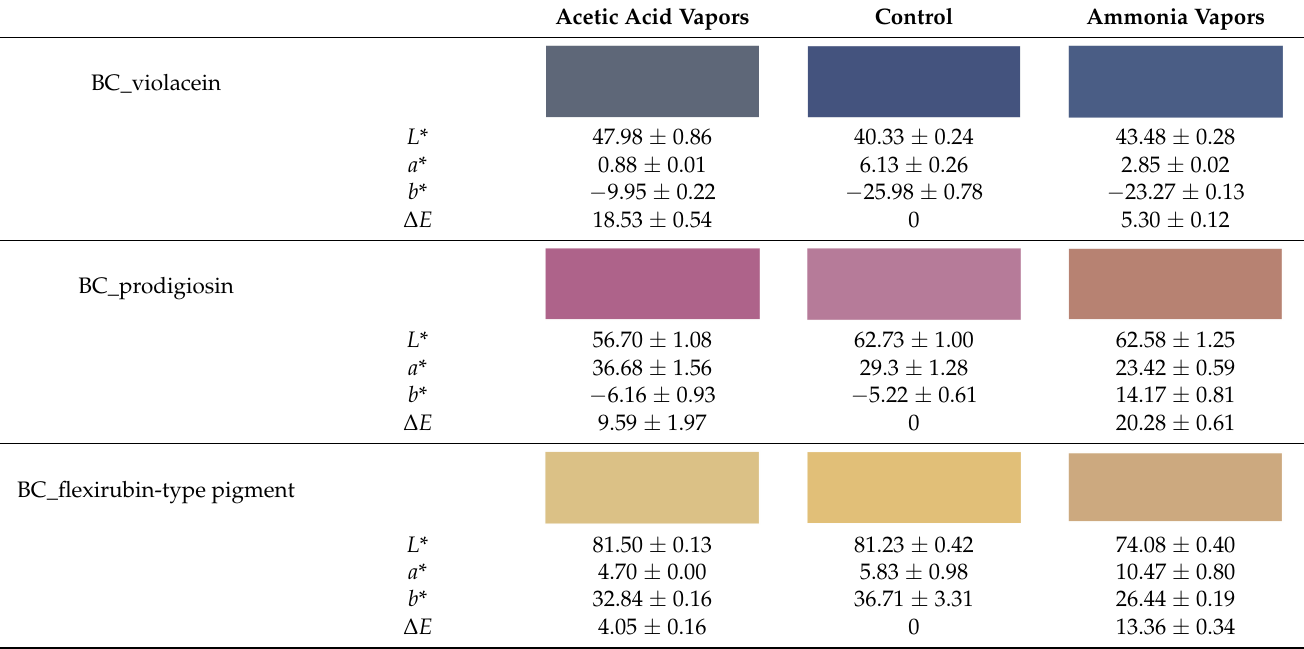
Table 8. Apparent color, colorimetric parameters, and total color difference ( ∆ E ) of the color indicators response to ammonia and acetic acid